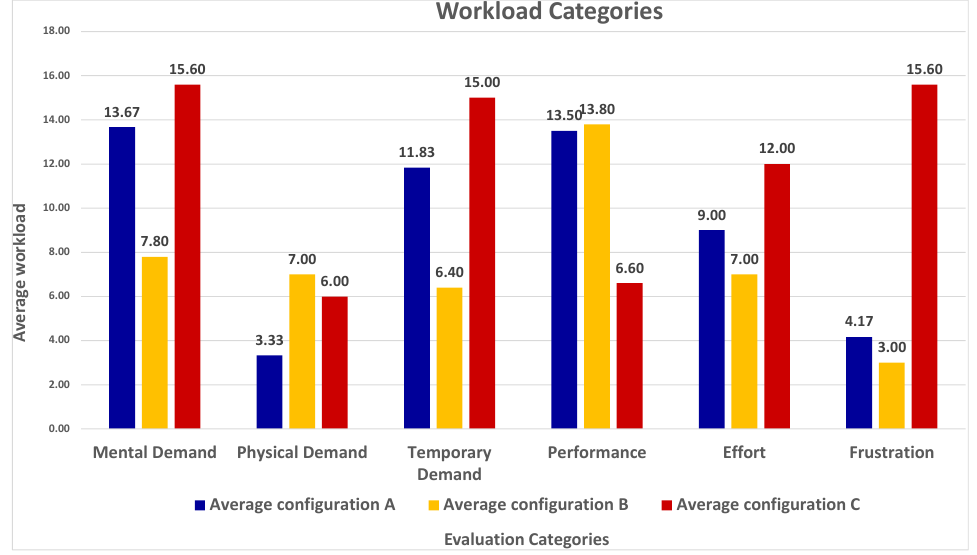
Figure 13. Results of the tests carried out using the NASA–TLX